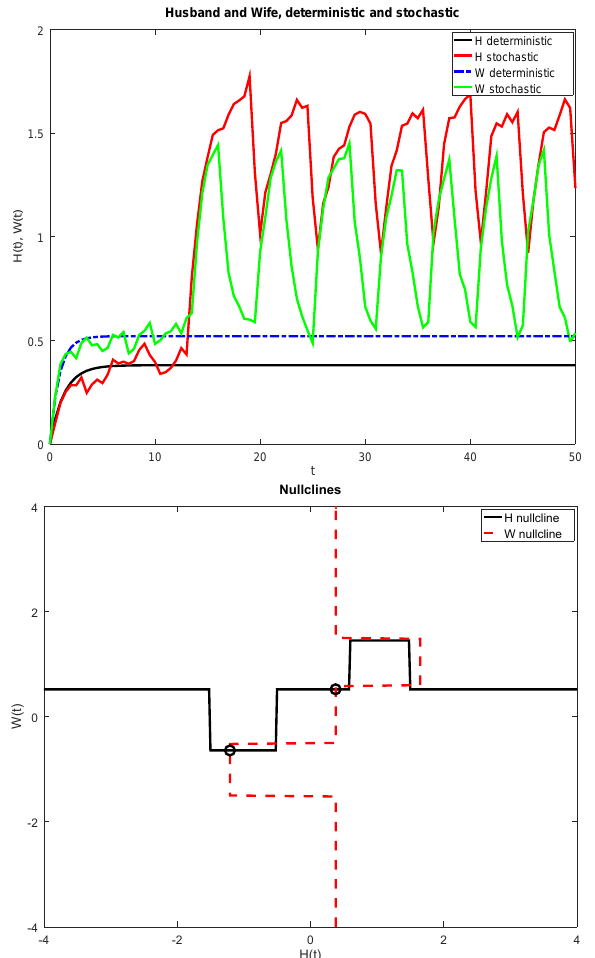
Figure 4. Piece-wise constant influence functions, scenario 2. Plot of H and W vs. time for the deterministic case and a stochastic realization ( top ) and a plot of the nullclines and the equilibrium points ( bottom ). In this example, the external white noise significantly changes the state of satisfaction of the